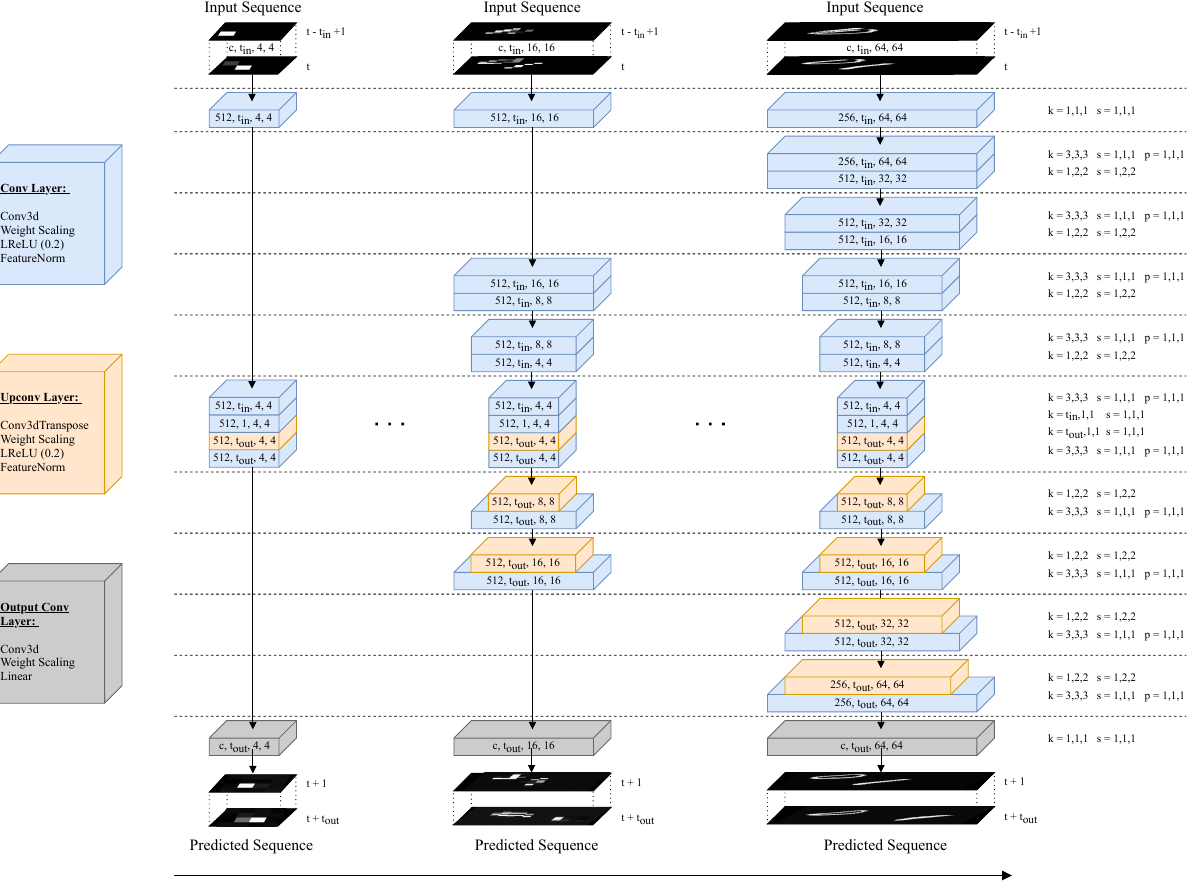
Figure 2. FutureGAN generator during training. We initialize our model to take a set of 4 × 4px resolution frames and output frames of the same resolution. During training, layers are added progressively to double the resolution after a specified number of iterations. The resolution of the input frames always matches the resolution of the current state of the network. This figure illustrates the growth progress of the generator exemplary for the MovingMNIST dataset with a final resolution of 64 × 64px. Intermediate 8 × 8px and 32 × 32px resolution steps are left out for visual